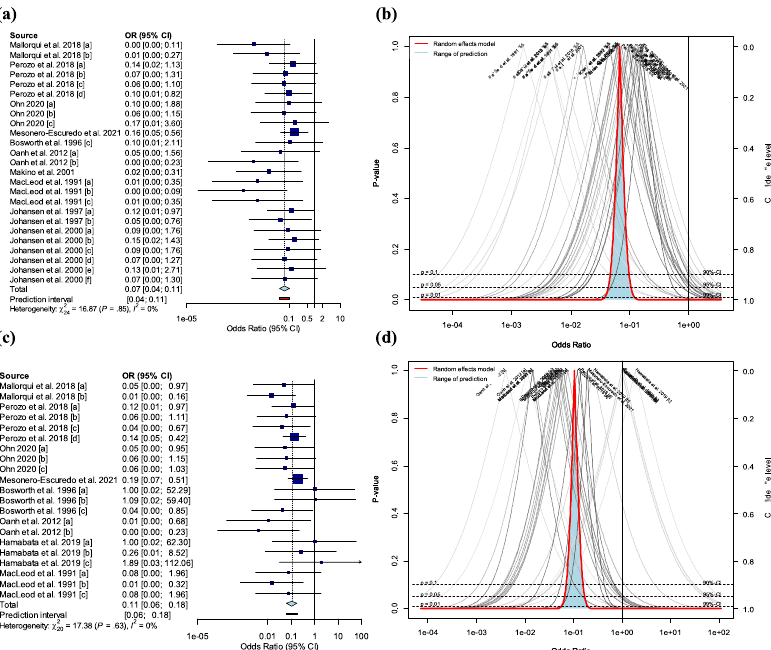
Figure 2. Results of conventional meta-analysis of edema disease-related mortality and clinical symptoms in pigs. ( a ) Forest plot of the odds ratio (OR) and 95% confidence interval for mortality from edema disease in pigs. Size of the blue square corresponds to the weight of each study. Vertical dotted and solid lines symbolize the overall effect size and the null value, respectively. A random-effects model was used. ( b ) Drapery plot showing p -value curves for mortality of edema disease. A random-effects model was used. ( c ) Forest plot of the OR and 95% confidence interval for clinical symptoms of edema disease in pigs. Size of the blue square corresponds to the weight of each study. Vertical dotted and solid lines symbolize the overall effect size and the null value, respectively. A random-effects model was used. ( d ) Drapery plot showing p -value curves for clinical symptoms of edema disease. A random-effects model was used. The statistical computer program R (version 4.1.1) was used to prepare this figure 44